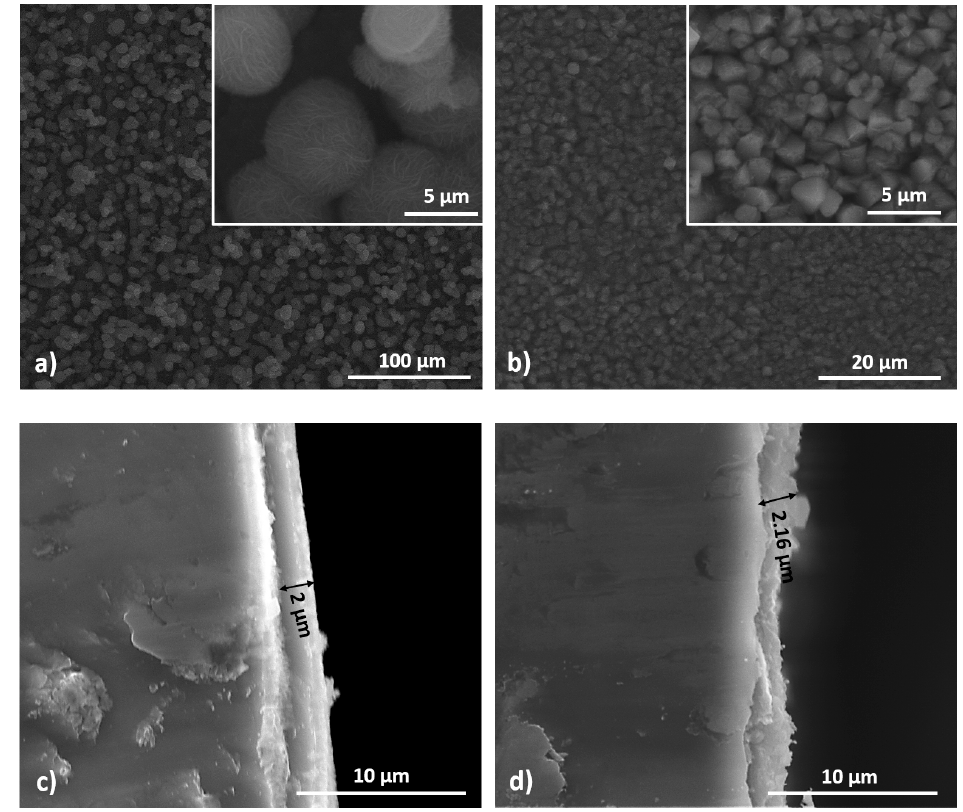
Figure 3. SEM images of the supercapacitor electrode surface obtained in a NaOH solution with a concentration of ( a ) 0.2 M and ( b ) 0.4 M. Cross-section images of electrodes obtained at ( c ) 0.2 M and ( d ) 0.4 M.